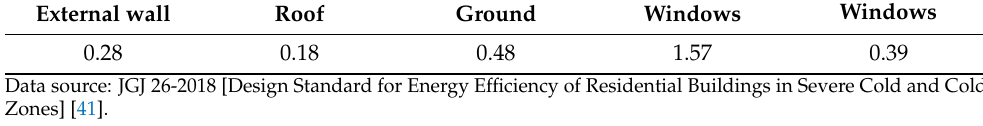
Figure 6. Envelope wall design for the residential building in Changchun. Table 3. U-values of building envelope in the simulation settings. U-Values for Different Components (W/m 2 K) g-Value of the